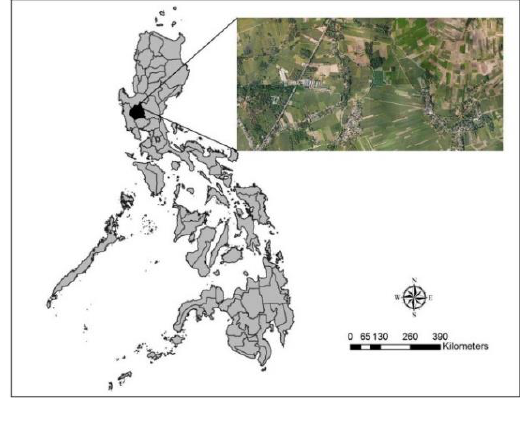
Figure 1. Aerial image of the study site